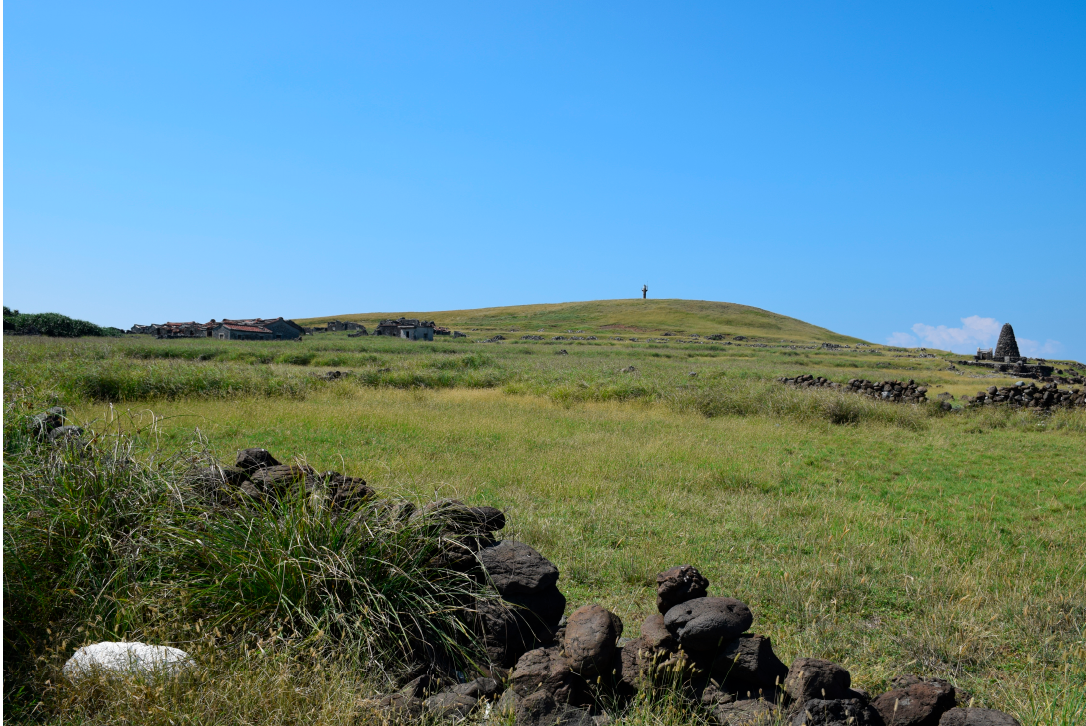
Figure 2. Vegetation garden wall.